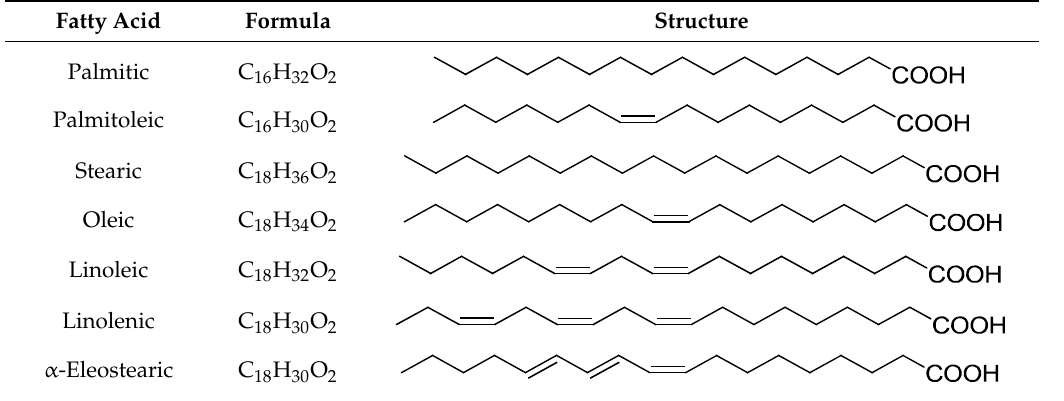
chains). chains). chains). chains). chains). Table 1. Formulas and structures of the most common fatty acids in vegetable chains). chains). Table 1. Formulas and structures of the most common fatty acids in vegetable oils Table 1. Formulas and structures of the most common fatty acids in vegetable oils chains). Table 1. Formulas and structures of the most common fatty acids in vegetable oils Table 1. Formulas and structures of the most common fatty acids in vegetable oils Table 1. Formulas and structures of the most common fatty acids in vegetable oils chains). Table 1. Formulas and structures of the most common fatty acids in vegetable oils Table 1. Formulas and structures of the most common fatty acids in vegetable oils Table 1. Formulas and structures of the most common fatty acids in vegetable oils